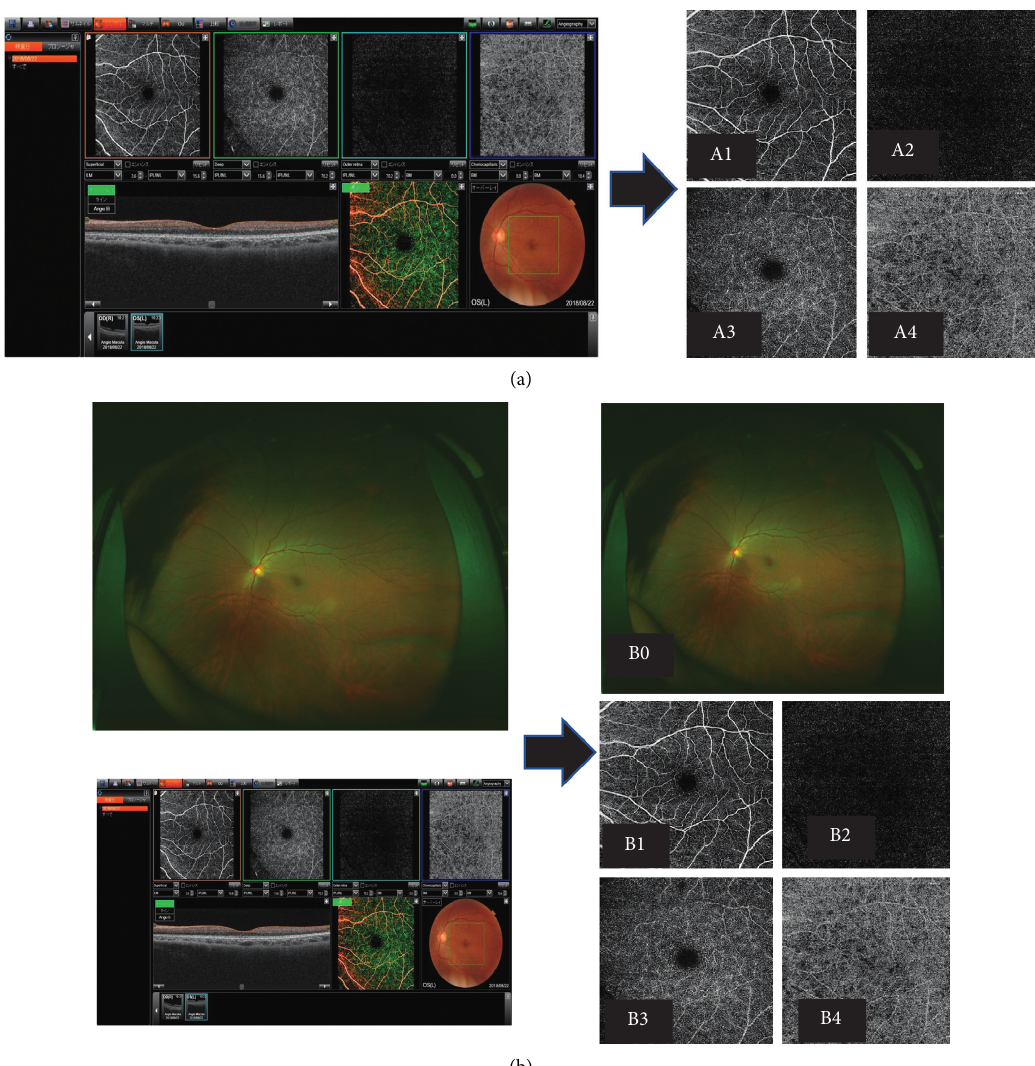
Figure 2: Test 1 (no apparent diabetic retinopathy [NDR] or diabetic retinopathy [DR]) and test 2 (NDR or proliferative diabetic ret- inopathy [PDR]) were performed using the Optos (a), optical coherence tomography angiography (OCTA), Optos (b), Optos OCTA images (A1–A4; B0–B4). A1, B1: Superficial OCTA image; A2, B2: deep OCTA image; A3, B3: other retinal layer of the OCTA image; A4, B4: choriocapillaris layer of the OCTA image; B0: Optos